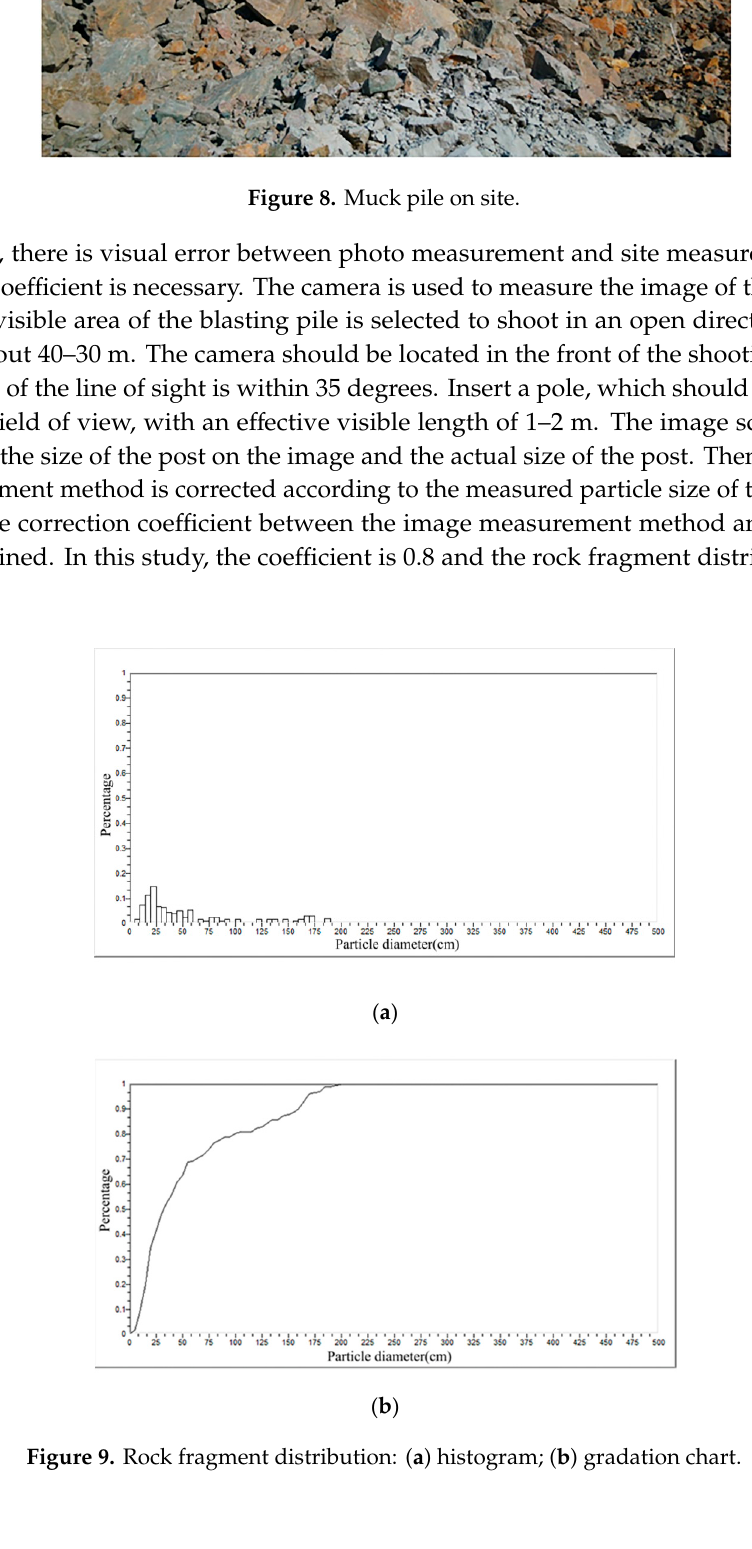
Figure 9. Rock fragment distribution: ( a ) histogram; ( b ) gradation chart.